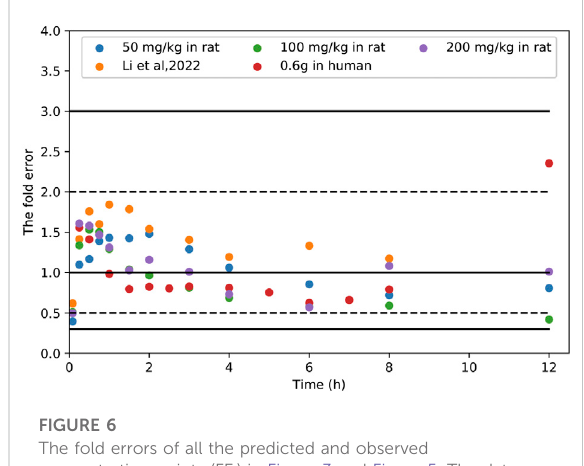
FIGURE 6 The fold errors of all the predicted and observed concentration points (FE i ) in Figure 3 and Figure 5. The data was calculated by Predicted i /Observed i . The 2-fold and 3-fold errors are indicated by dashed and solid black lines,